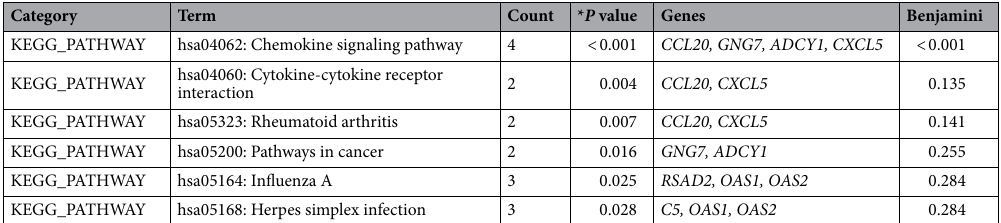
Table 1. The KEGG enrichment pathways of 13 validated genes expression in DAVID database.